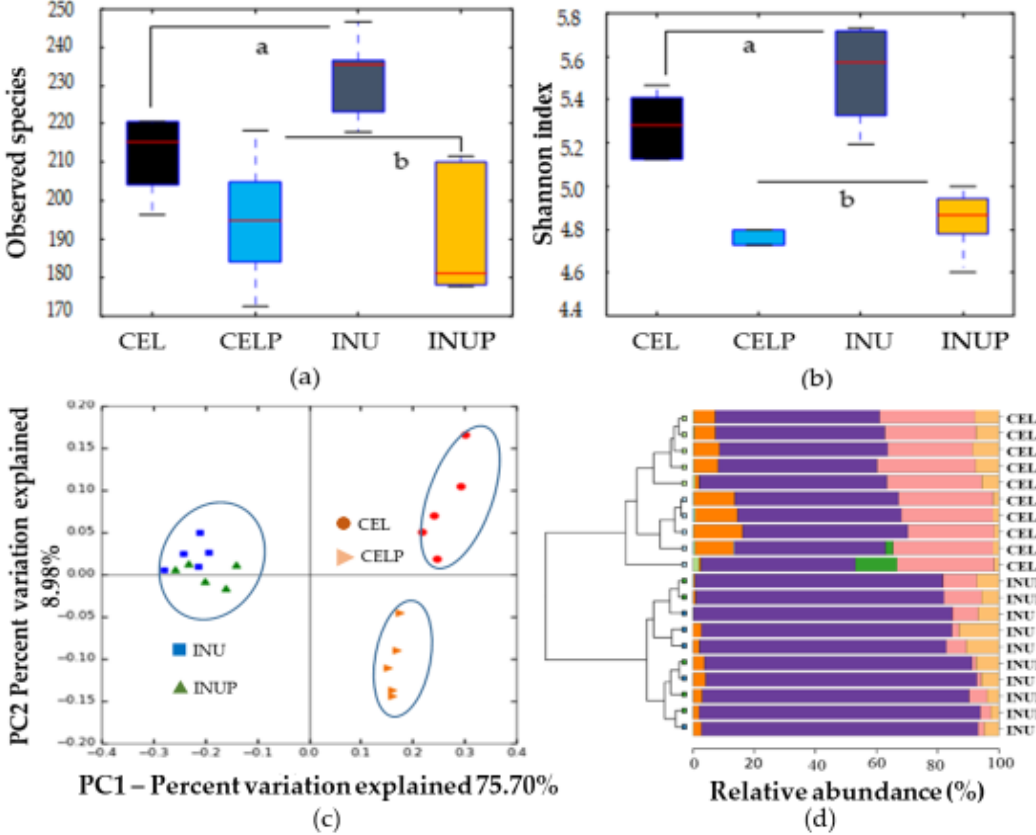
Figure 1. α -diversity (observed species ( a ) and Shannon diversity index ( b )), β -diversity ( c ) and clustered bar-chart ( d ) comparisons of microbiota during in vitro colonic fermentation of 3% cellulose (CEL), 3% cellulose + 0.16% PSP (CELP), 3% inulin (INU), and 3% inulin + 0.16% PSP (INUP). Observed species (a) and Shannon diversity index (b) were compared by using the non-parametric Kruskal – Wallis rank sum test. Different letters are significant at p < 0.05.